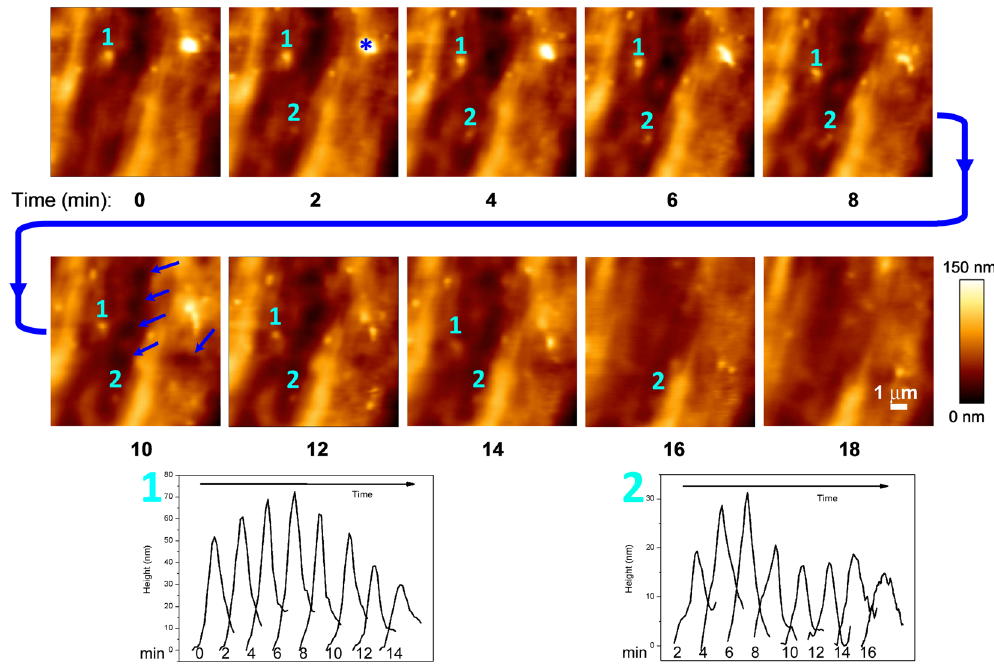
Figure 2. Sequence of AFM measurements in living cells. The topography of a 10 × 10 μ m area on the cell surface of one cell is depicted. Lapse to record consecutive images at 128 × 128 pixels: 2 minutes (line rate around 1 Hz). The outer surface of ADSC membranes is highly dynamic and show protrusions that bulge, move and disappear within minutes. Below, the graphical evolution of two of these protrusions is depicted: #1 is a protrusion already present at time 0 that moves more than 2 µ m before disappearing by min 16; #2 is a protrusion that emerges by min 2, grows and shows a sudden decrease by min 8, that can be interpreted as a partial shedding, while a smaller portion remains and disappears by min 18. Asterisk ( * ) marks a medium sized protrusion that divides into several smaller ones. Short-lived membrane depressions are also observed. Some of these depressions are of large diameter (arrowheads, sixth frame), while most of them are of small size. However, these small-sized depressions cannot be unambiguously identified as